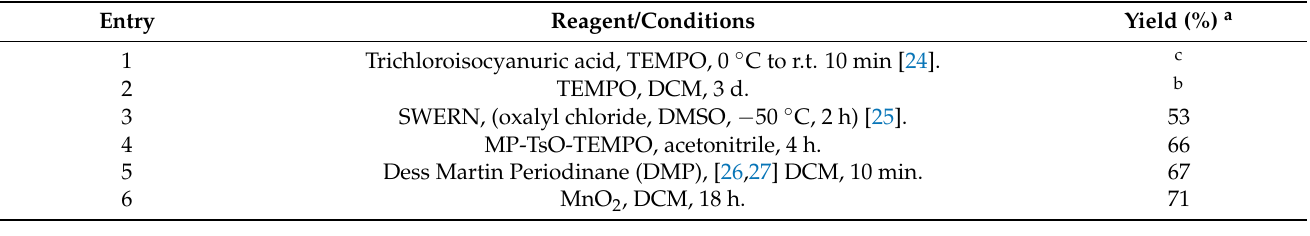
Table 1. Oxidation conditions investigated. a Isolated yield. b Only starting material isolated. c Incorrect product isolated, mono-chloro substitution occurred (Scheme